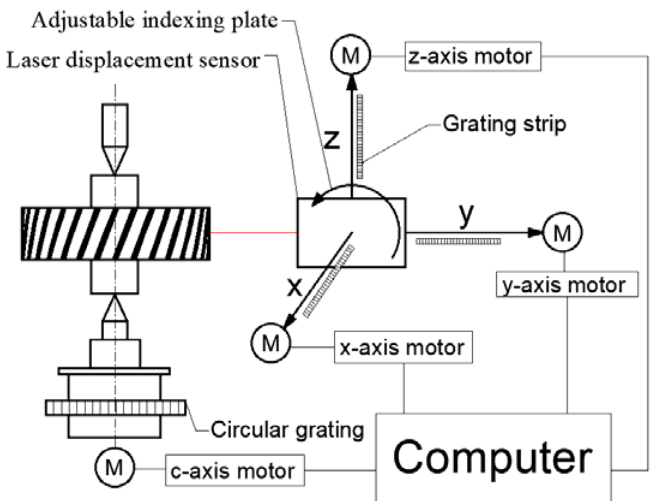
Figure 7. Measurement system.